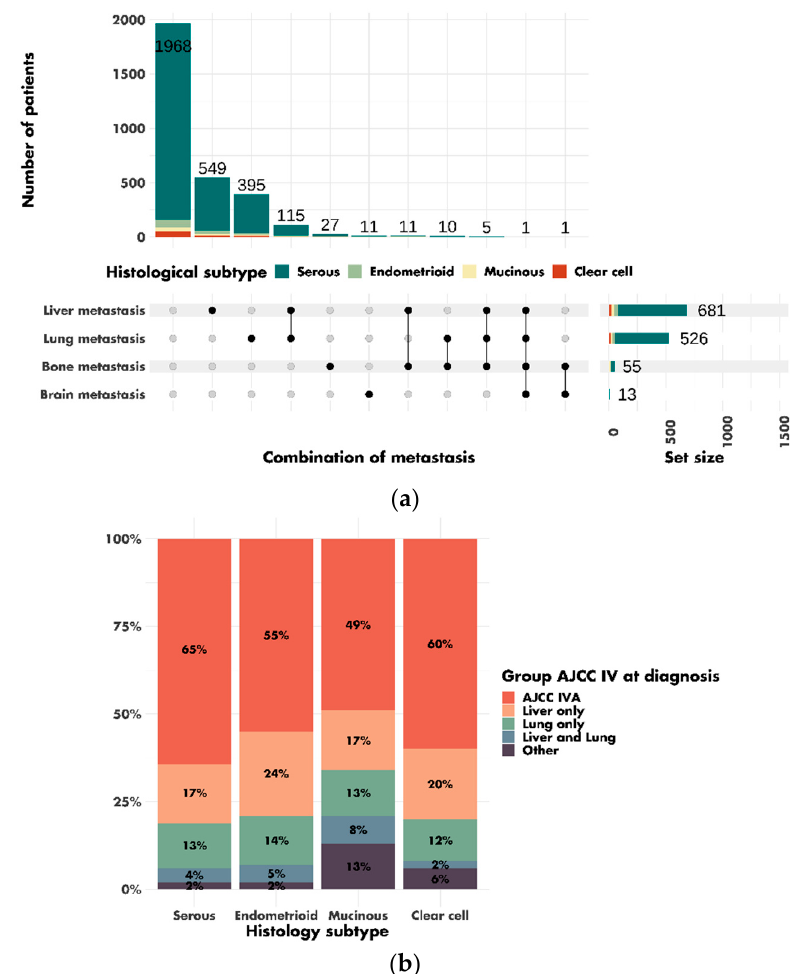
Figure 2. Combinations of metastases in patients with AJCC stage IV tumors at diagnosis: ( a ) de- scription of the different combinations of metastases; ( b ) distribution of associations of metastases by histological subtype ( p < 0.001).